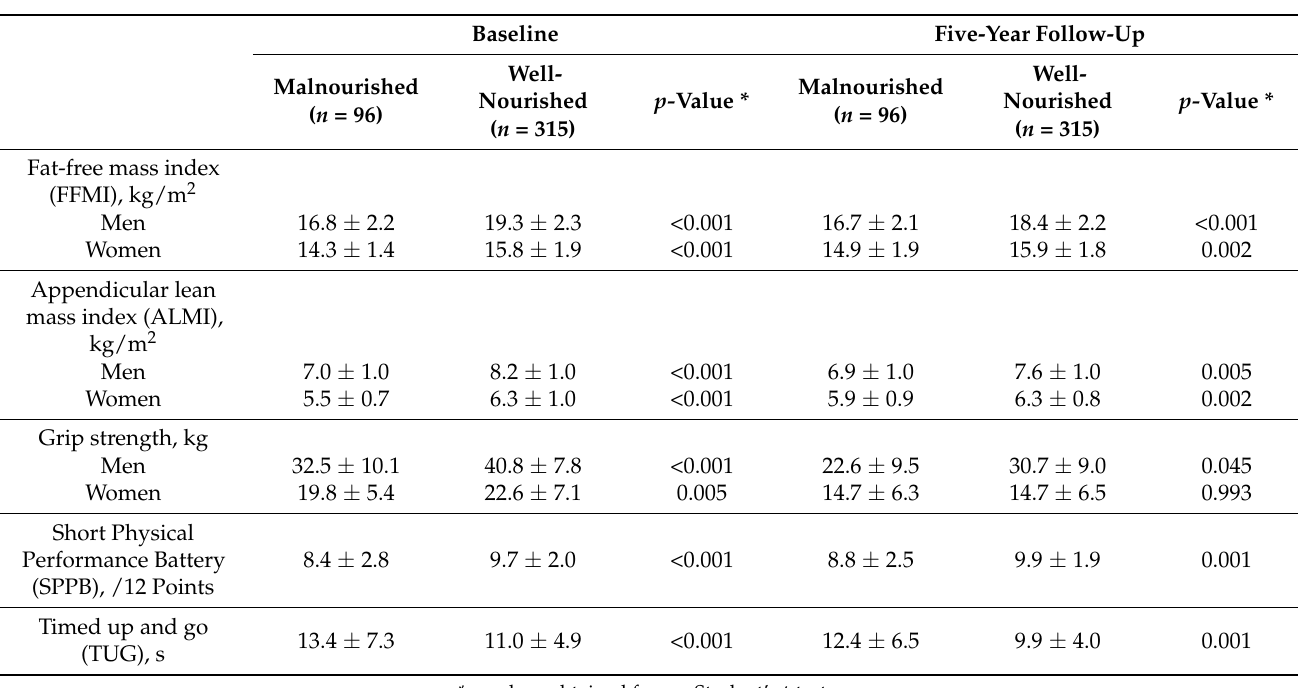
Table 2. Muscle parameters at baseline and at five-year follow-up according to nutritional status ( n =